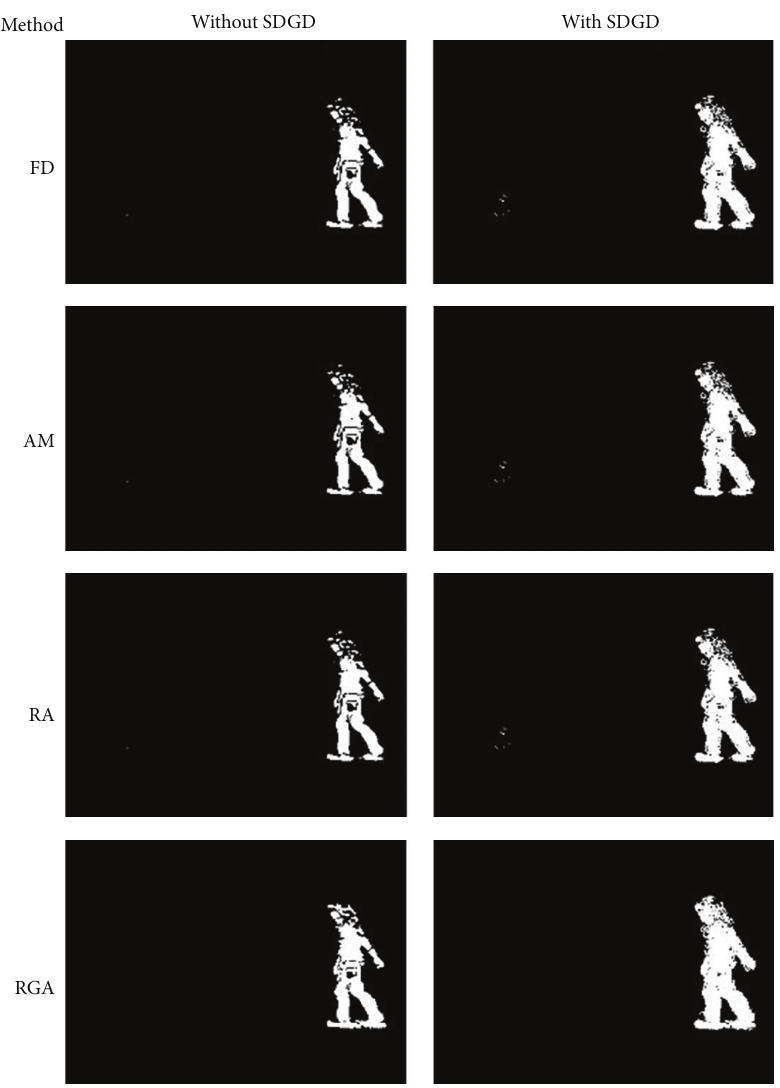
Figure 5: Segmentation performance using various background subtraction techniques for an outdoor